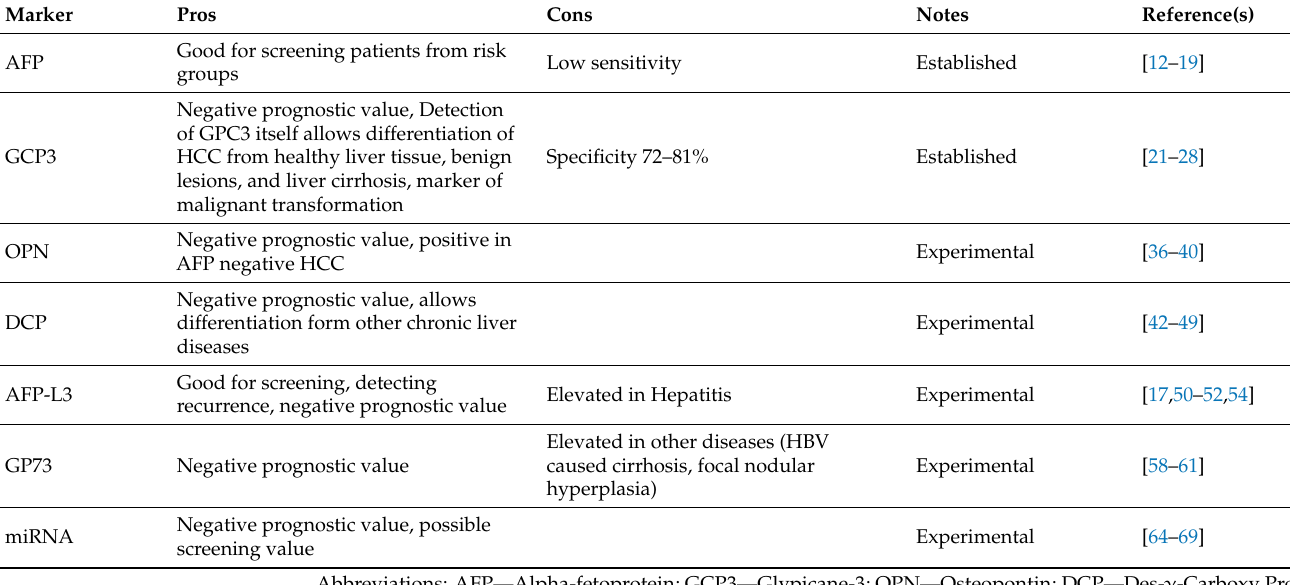
Table 1. Some of the current and additional markers for early detection of HCC.